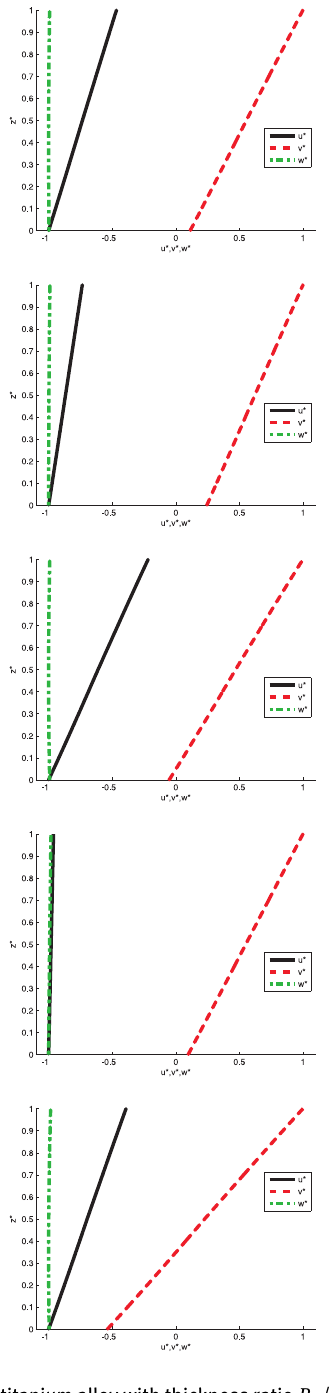
The eleventh benchmark considers a square sandwich are completely different from those of the skins. This fea- plate with isotropic aluminium skins and an isotropic core ture is confirmed by the results given in Table 18. The er- in PVC. In this case the transverse anisotropy is very big rors given by the 2D FE code are acceptable only for thin because the elastic and mechanical properties of the core plates (a/h=1000 or 100) but they are too large for